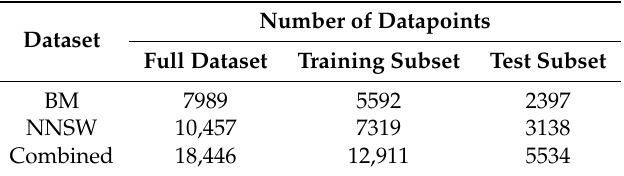
Table 3. Number of datapoints (road segments) of the target variable (average speed) y i for each of the three